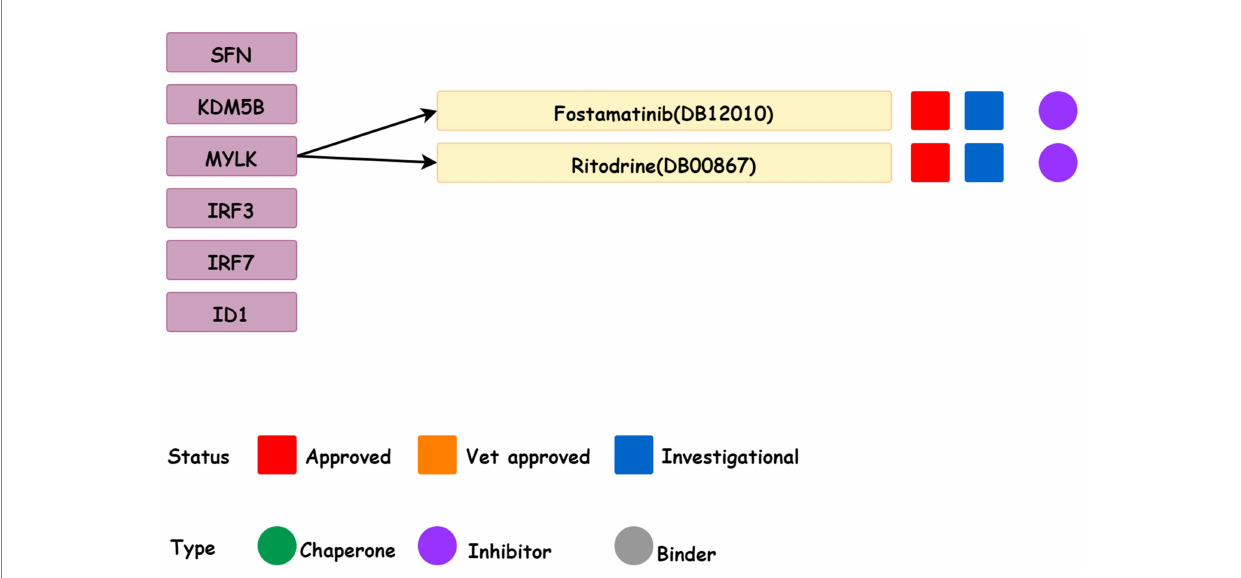
FIGURE 10 Drugs for the six candidate genes obtained from the DrugBank database.